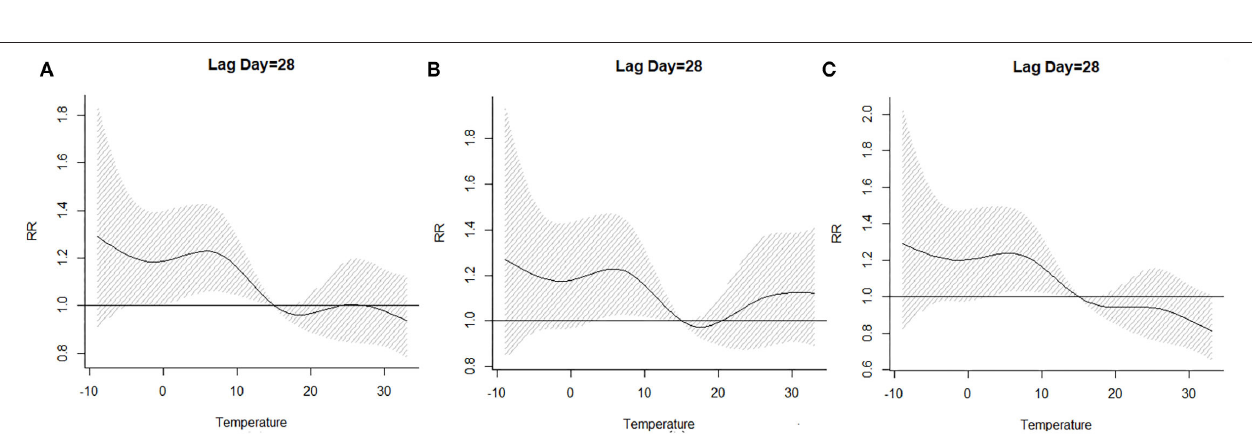
FIGURE 4 | The effect of temperature on the hospitalization when lag day was on 28 [ (A) whole; (B) men; (C) women]. RR, relative risk.